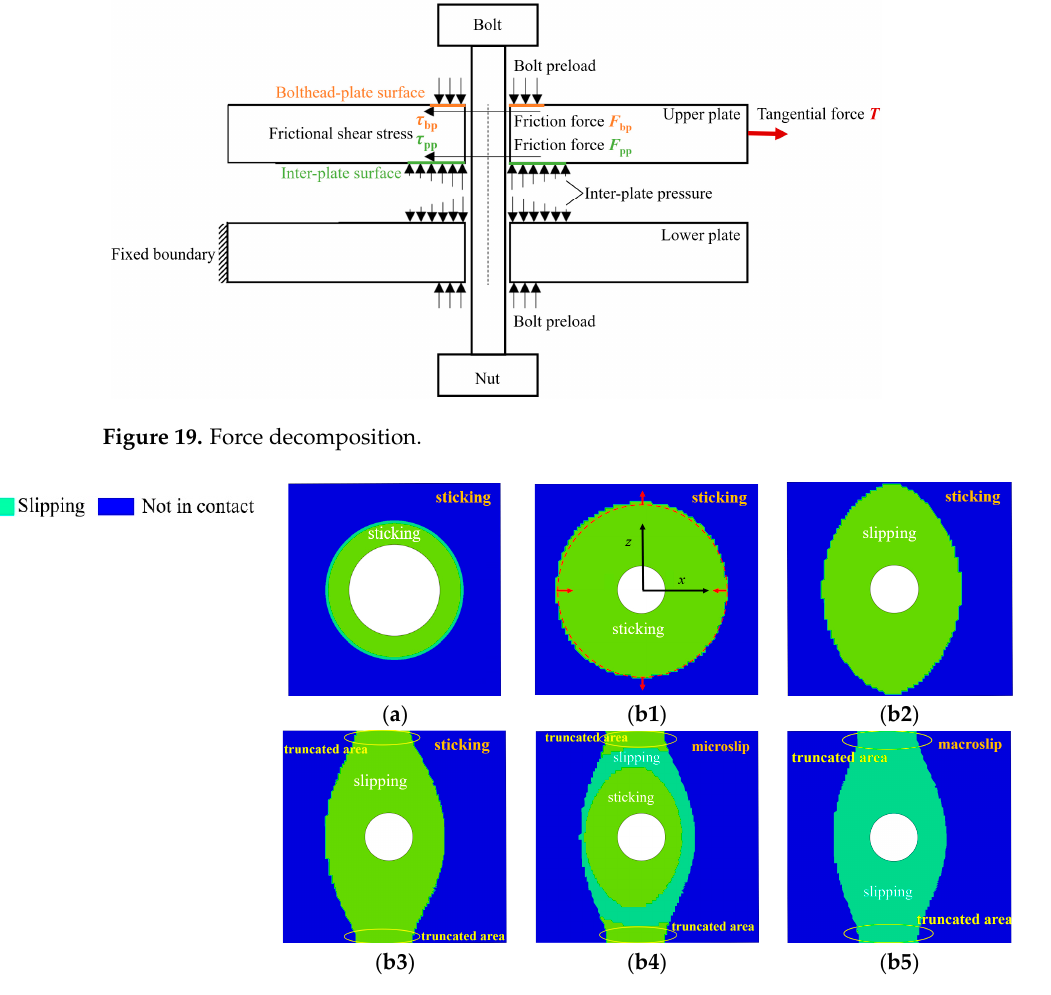
F is a static fric- bp